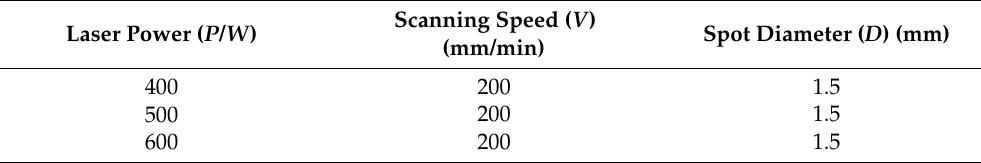
Table 3. Parameters governing the laser remelting